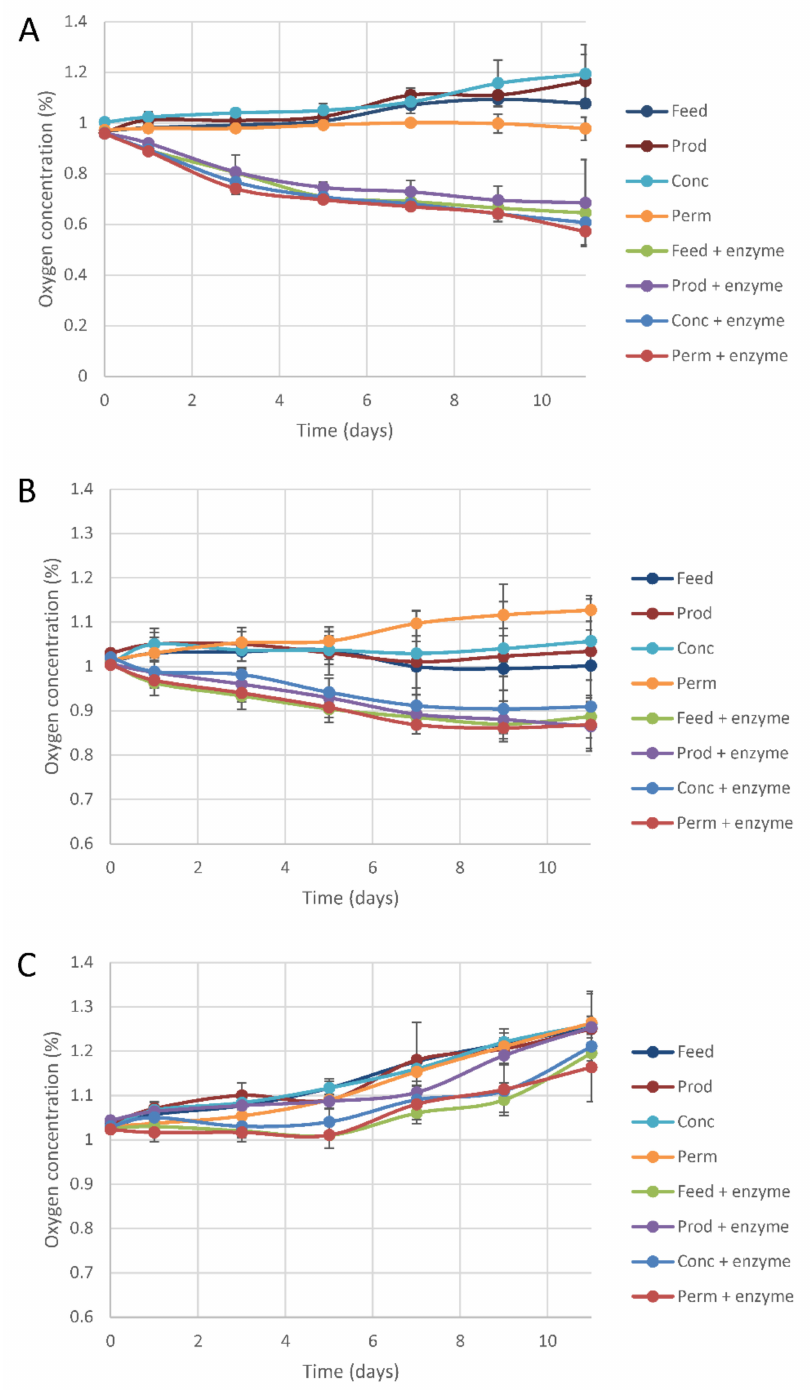
Figure 4. Oxygen contents of sealed reaction chambers containing coated boards with lignosulfonate preparations and active or denatured laccase during incubation at an RH of ( A ) 100%, ( B ) 92%, and ( C )